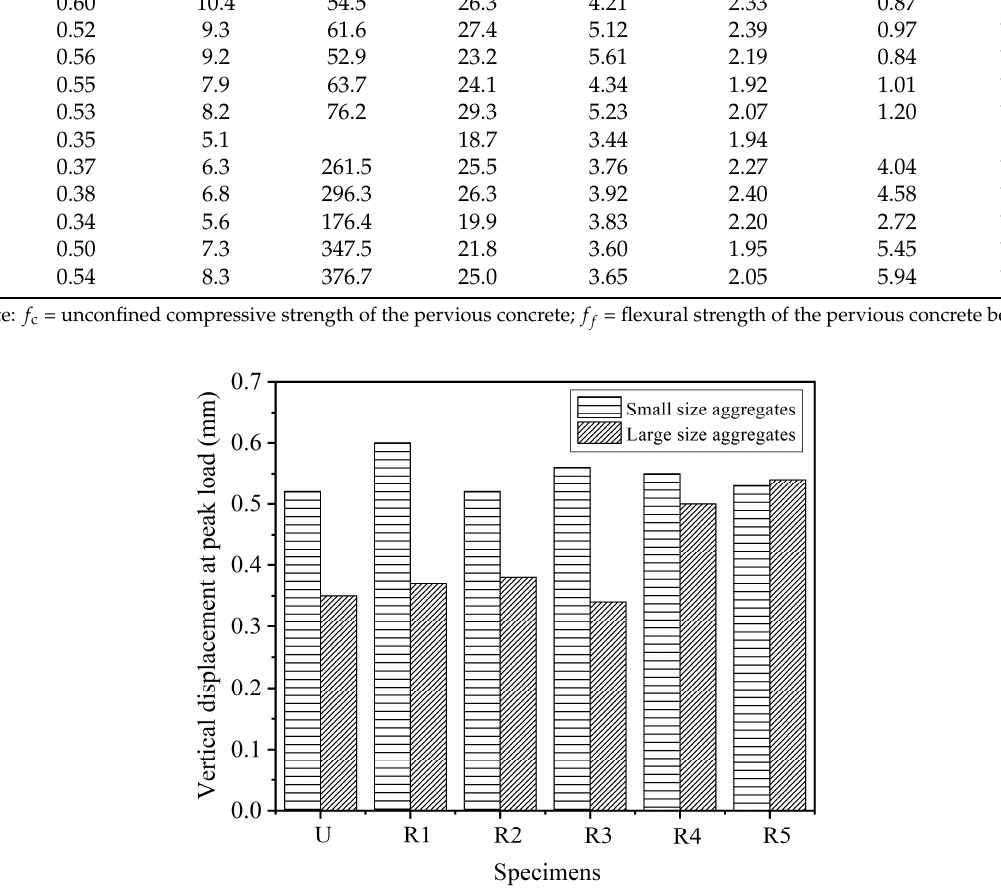
Table 4. Energy absorption and toughness index.